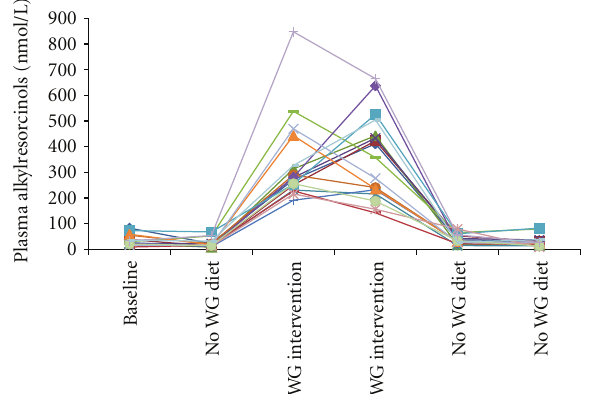
Figure 4: An example of interindividual variation of plasma alkylresorcinols under controlled conditions. The wholegrain inter- vention delivered approximately 62 mg alkylresorcinols/d. Each time point is one week apart. Data are from